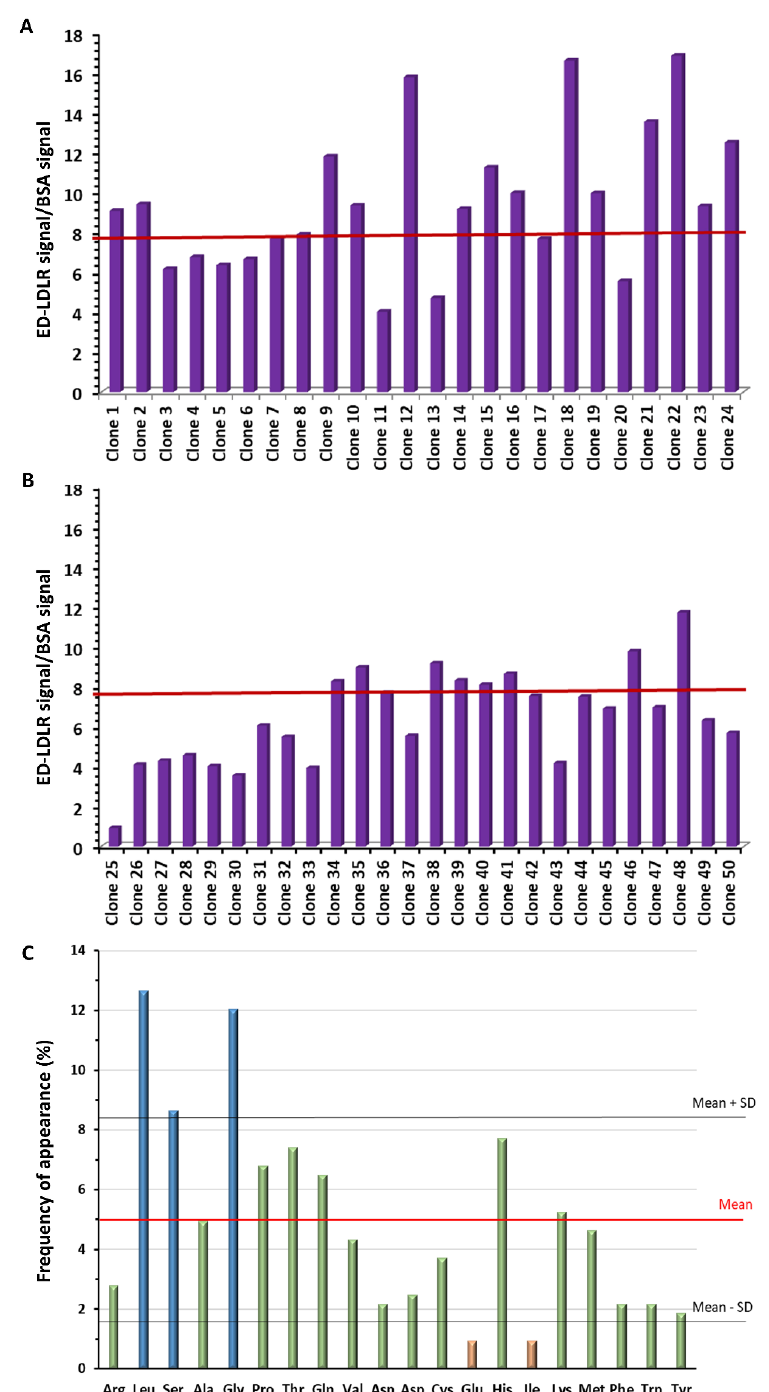
Figure 1. ( A , B ) Specific binding of the 50 clones isolated from the pool of the 3rd round of panning, determined by the ratio between the binding to the extracellular domain of low-density lipoprotein receptor (ED-LDLR) relative to bovine serum albumin (BSA) (see Figure S1). ( A ) Clones 1 to 24. ( B ) Clones 25 to 50. ( C ) Frequency of amino acids in the 13 different peptide sequences obtained after DNA sequencing.